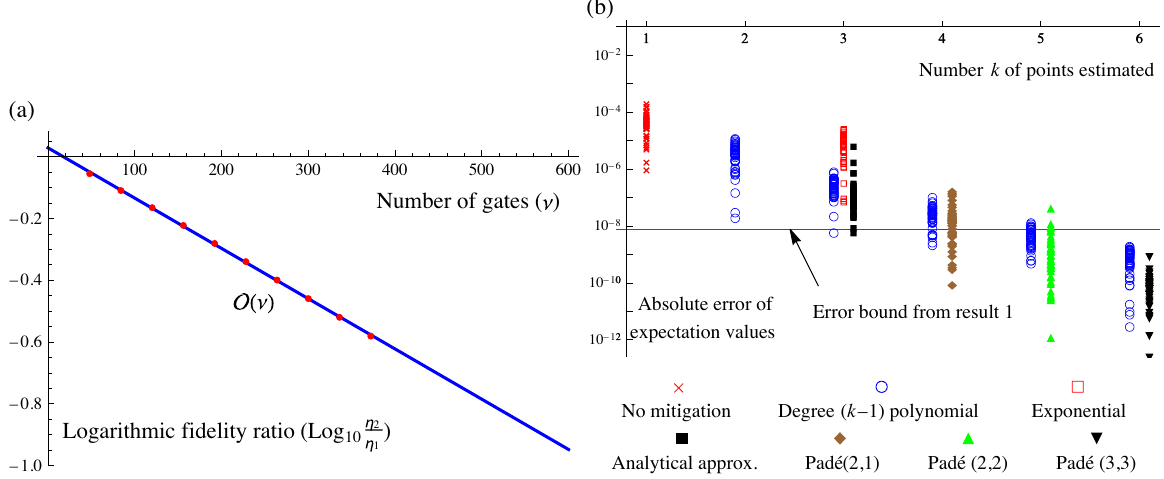
FIG. 6. (a) The fidelity η 1 decreases purely due to the coherent mismatch while the fidelity η 2 decays purely due to the incoherent effect of the noise channel as discussed in Appendix C 1. The ratio η 2 = η 1 appears to decay exponentially in the investigated region (linear in the logarithmic plot) when we increase the number of gates for the fixed 2-qubit gate error ϵ ¼ 10 − 2 and this ensures us that the coherent mismatch in the dominant eigenvector becomes negligible for large systems (large ν ). We simulated the same circuit as in Fig. 5(b). (b) Mitigating the error caused by a coherent mismatch in the dominant eigenvector of the density matrix as discussed in Appendix C 1. Gate error levels in the state-preparation stage were varied in k ¼ 2 ; 3 ; 4 ; … steps and the obtained expectation values were extrapolated to the zero error limit. The red horizontal line represents the error bound from result 1, and one can straightforwardly suppress the effect of the coherent mismatch below this error bound by fitting low-order polynomials. The error saturates when increasing the degree of the fitting polynomial and can only be further reduced by increasing the number n of